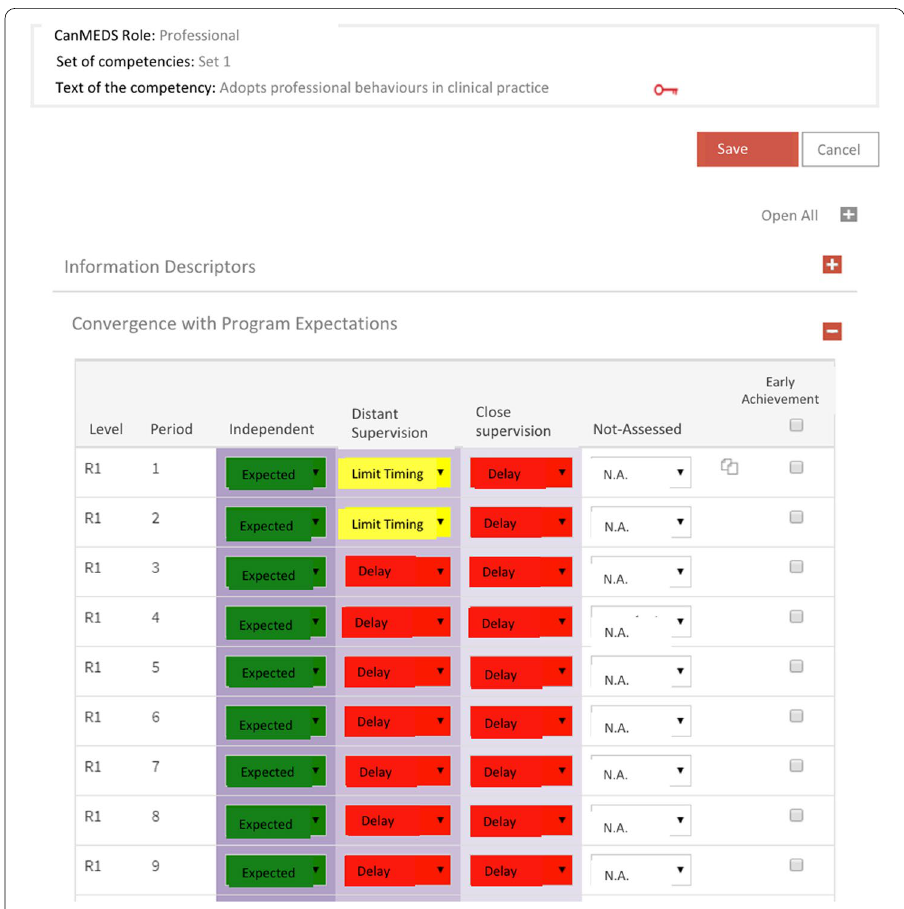
Fig. 5 Table of correspondence between the level of supervision descriptors and program expectations (developmental